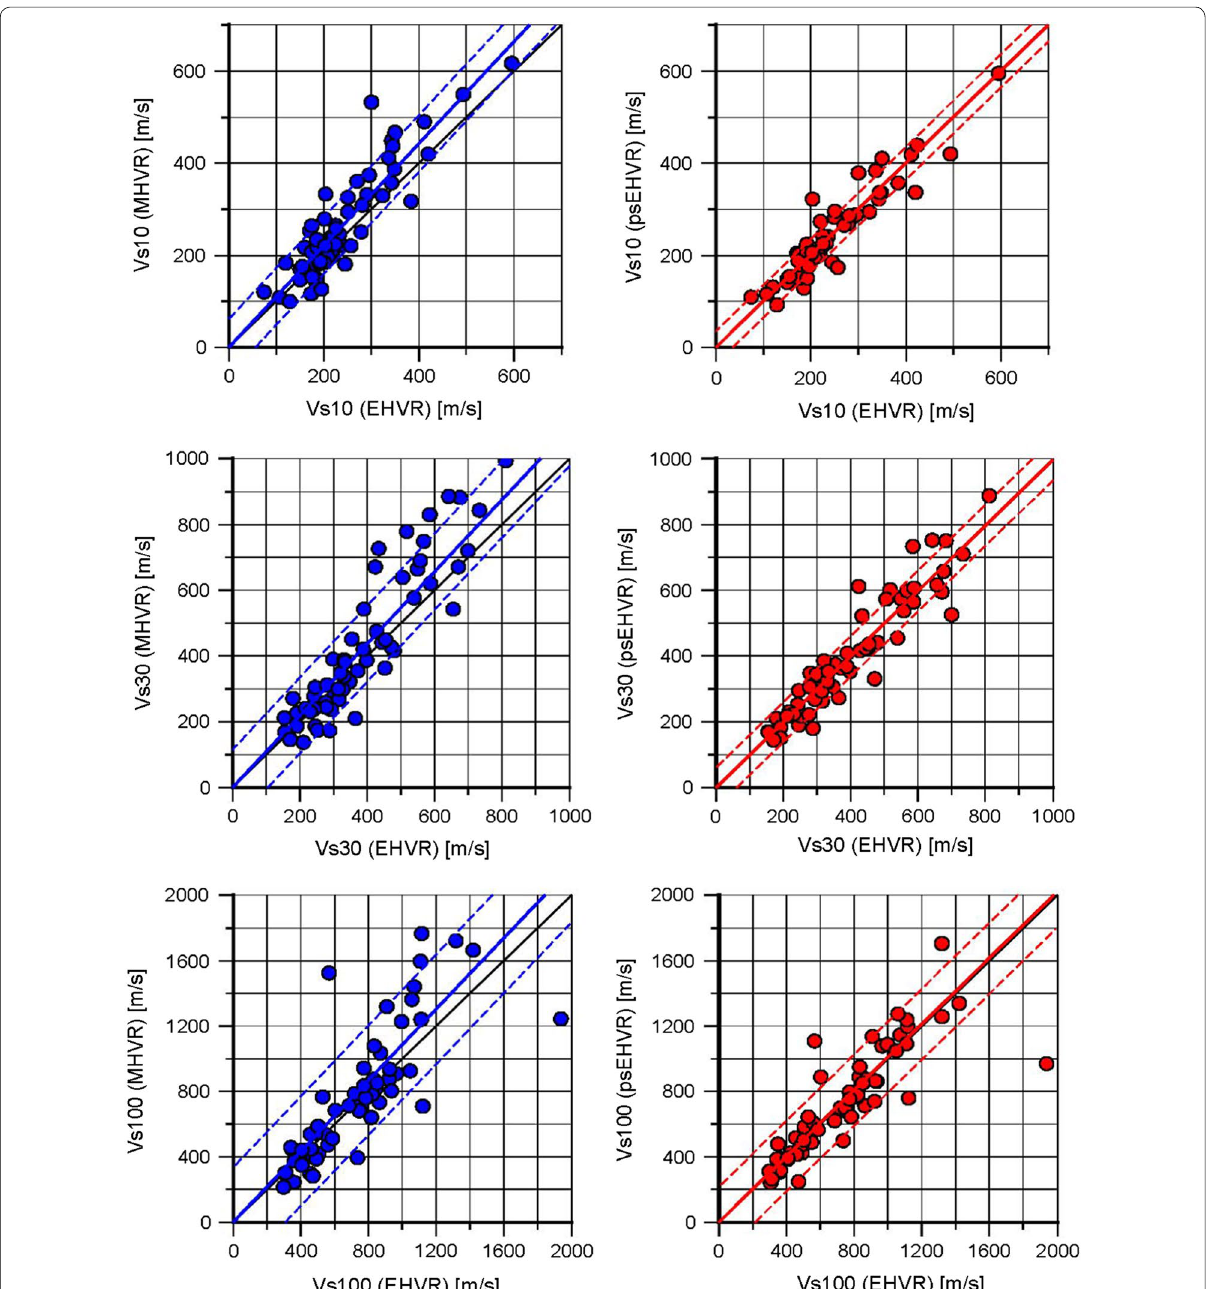
Fig. 17 Comparison of the averaged velocities from pEHVR inversion or MHVR inversion (vertical axis) with respect to those from EHVR inversion (horizontal axis). Each panel shows those for top 10 m (top), 30 m (middle), and 100 m (bottom). Inversions from MHVR (left) and those from pEHVR